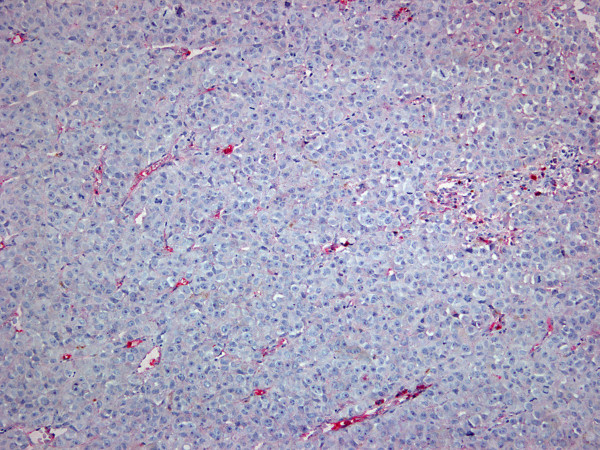
Immunohistochemical staining for bFGF in group II (sham operated): More microvessels are represented in the margin of the tumor.